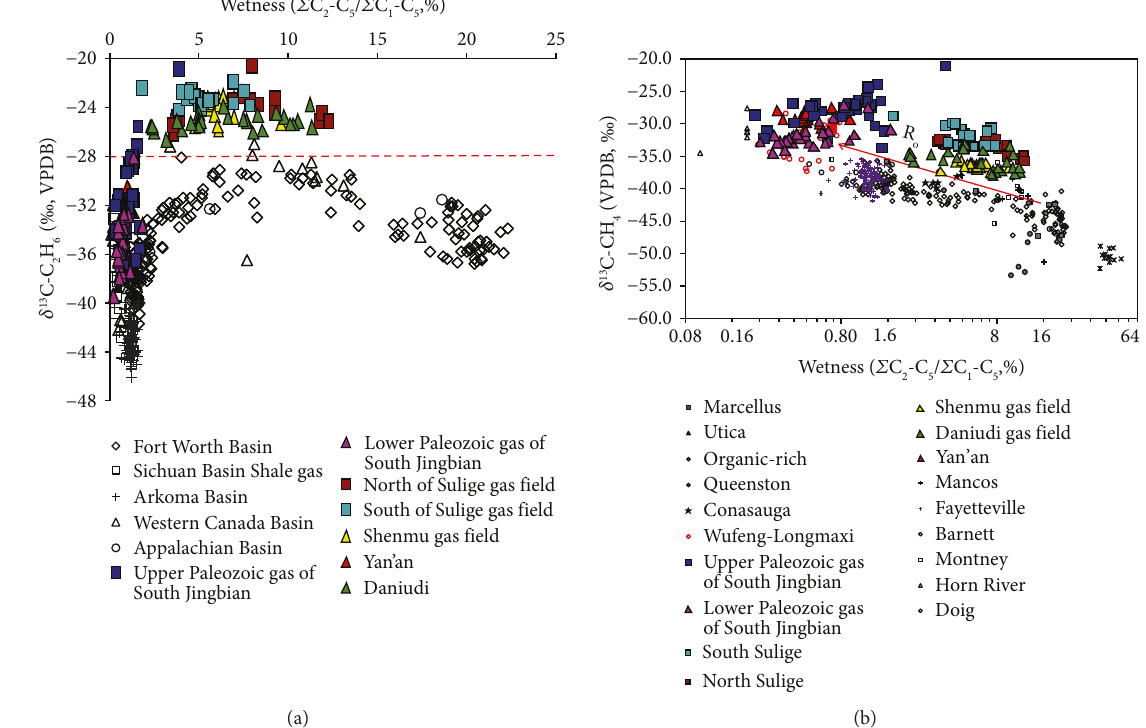
Figure 6: (a) δ 13 C-C H versus wetness (modi fi ed from [15]); (b) δ 13 C-CH 2 6 in (a) and (b) are as follows: [13, 24 – 27, 29, 30]; from [14 – 16, 28, 31]).